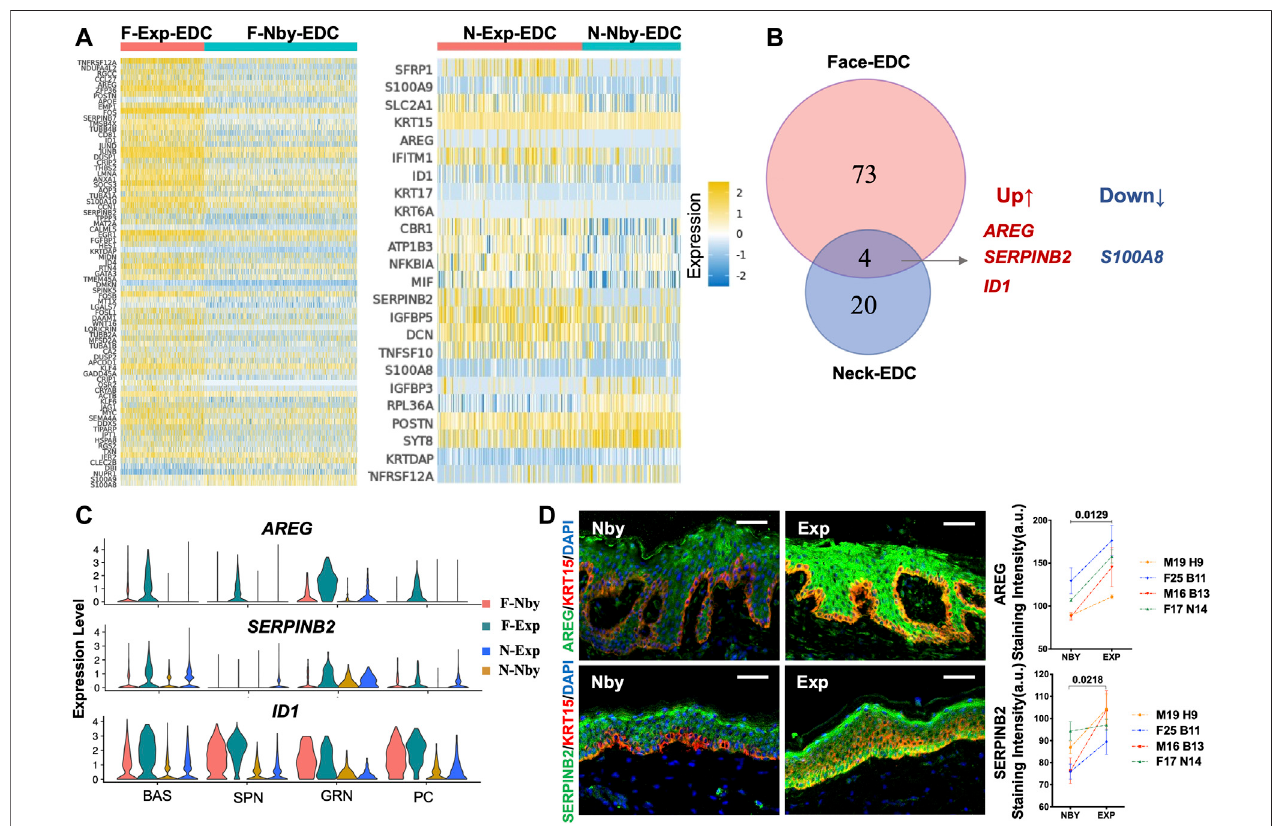
FIGURE 5 | Identi fi cation of the differentially expressed genes (DEGs) in the EDC subpopulation during LTE. (A) Heatmaps showing the DEGs identi fi ed in EDC betweentheexpandnbygroups.Thecolorkeyfrombluetoyellowindicateslowtohighgeneexpressionlevels.Representativegenesarelistedtotheleft(|FC| ≥ 0.5). (B) Venn diagram showing the overlap between DEGs in Face-EDC vs. Neck-EDC (|FC| ≥ 0.5). (C) Violin plots showing the expression level and distribution of the selected DEGs in subpopulations (BAS, SPN,GRN)and proliferative cells(PC) in four samples. (D) Representative IF images oftheAREG and SERPINB2 staininginnearby and expanded skin from four other individuals and their quanti fi